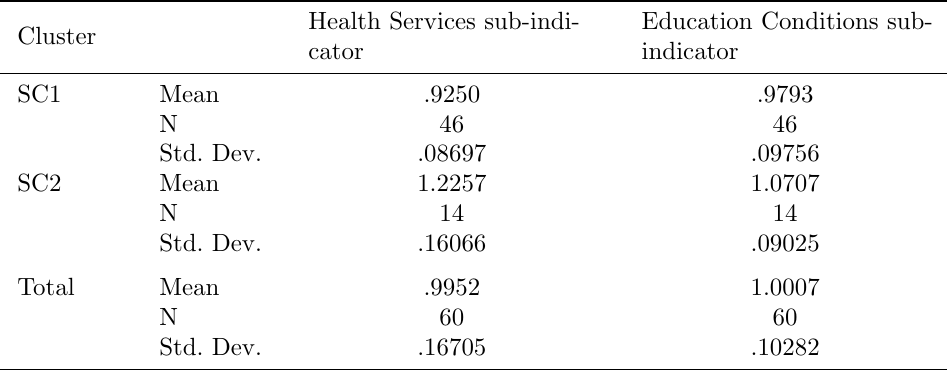
Table 8: Summary Report of the clustering based on the regions’ health and education characteristics